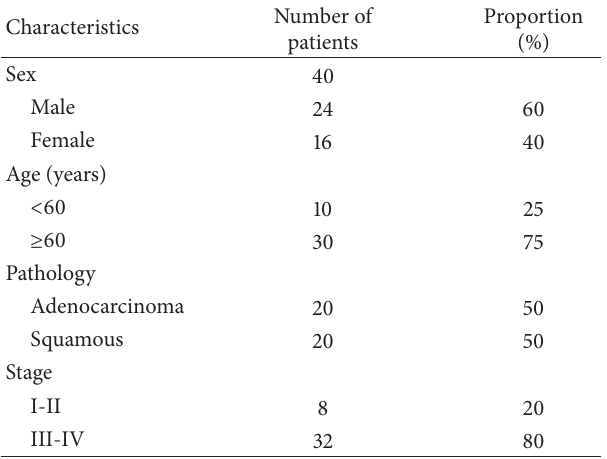
Table 1: Clinical and pathologic characteristics of patients ( n =